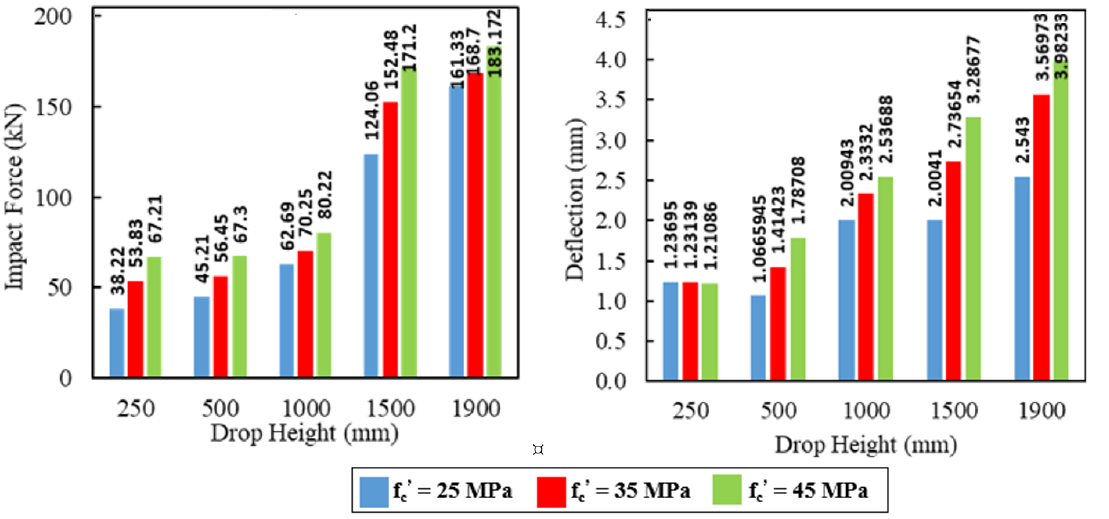
Figure 22. The effect of concrete compressive strength on the impact forces and mid-span deflections for the composite specimen CGC-I.